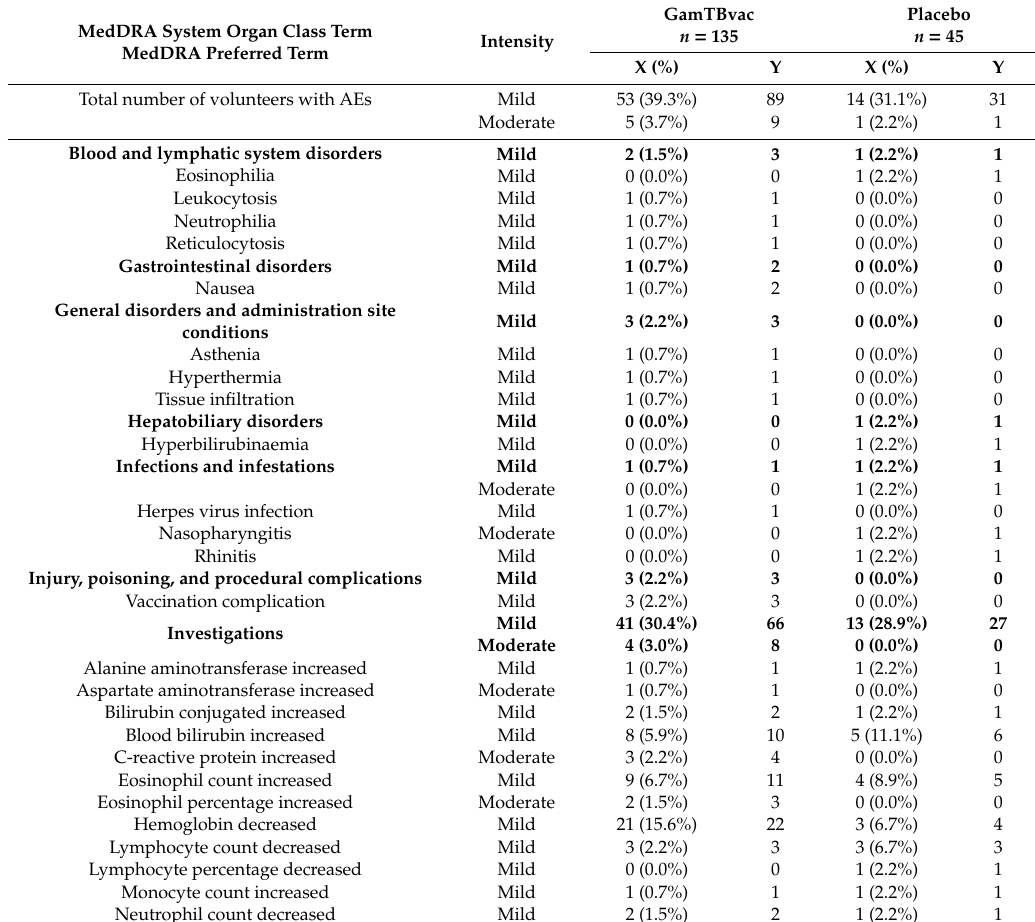
Table 2. Unsolicited AEs and their intensity, safety evaluation set, n = 180. X = Number of volunteers with at least one AE; % = Percentage of volunteers with at least one AE in the group; Y = Total number of events. MedDRA (Medical Dictionary for Regulatory Activities) System Organ Class Term is written in